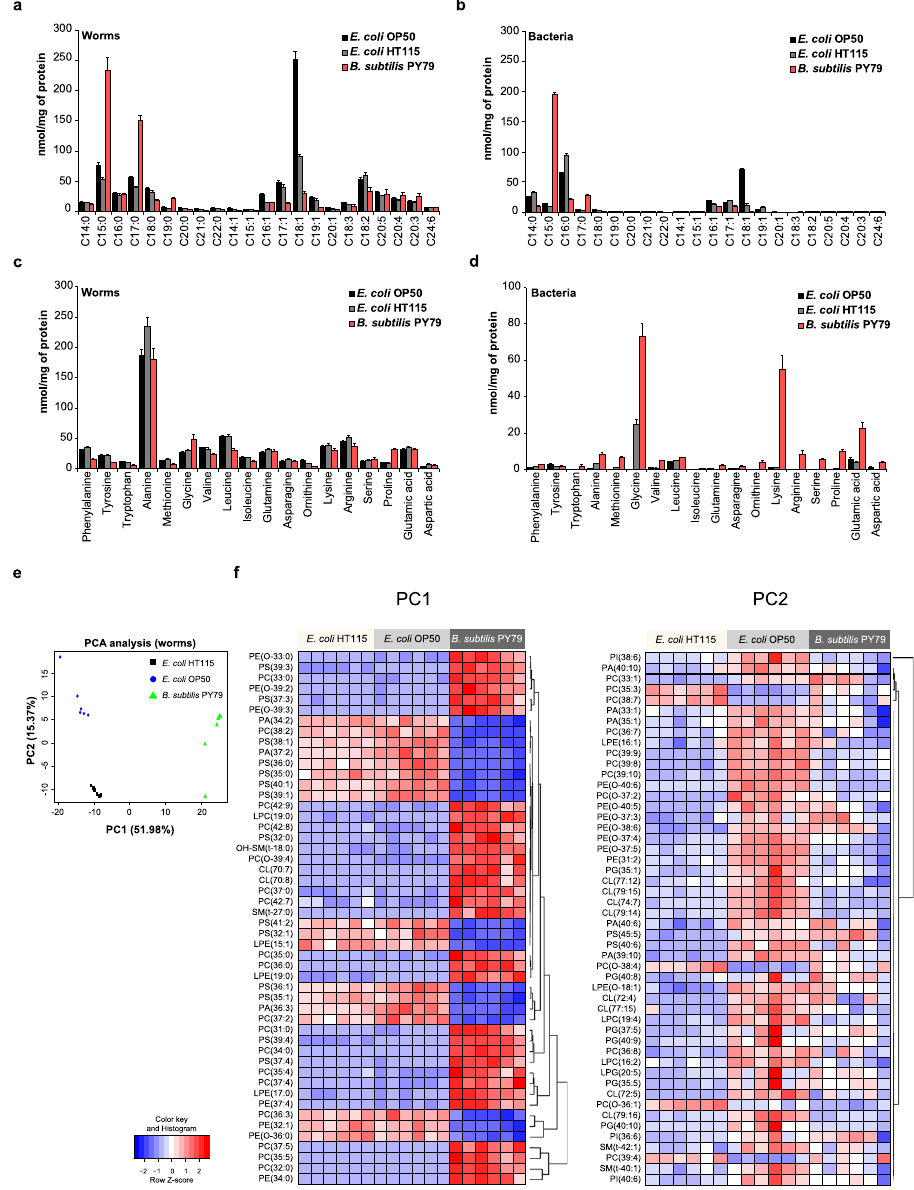
Figure 8. Metabolite changes in worms exposed to different bacterial diets. The effect of dietary intervention on worm metabolism was investigated by feeding N2 worms with three types of bacteria including E. coli OP50, E. coli HT115 and B. subtilis PY79. ( a ) FA composition of N2 worms fed with different bacterial diets. Worms fed an E. coli OP50 diet accumulated the highest abundance of C18:1 fatty acid. A relatively high abundance of C18:1 was also found in worms fed with the other E. coli strain HT115. Worms fed a B. subtilis PY79 diet accumulated odd chain fatty acids, such as C15:0 and C17:0. ( b ) FA composition of the three bacterial diets. The two E. coli bacterial strains were enriched with C14:0, C16:0 and C18:1, while B. subtilis PY79 bacteria were enriched with odd chain fatty acids C15:0 and C17:0. Polyunsaturated FAs were absent in all three bacterial strains. ( c ) AA composition of N2 worms fed with different bacterial diets. AA profiles of worms fed with different bacterial diets did not display marked changes. Worms fed the E. coli strains showed similar AA profiles, while feeding worms with a B. subtilis diet showed a high abundance of proline. ( d ) AA composition of the three bacterial strains. E. coli strains contained low levels of most AA species, except glycine, which is relatively high abundant in E. coli HT115. B. subtilis PY79 bacteria were enriched in many AA species, especially glycine, lysine and glutamic acid. ( e ) Principal Component Analysis (PCA) score plot showing group separation based on PL profiles in N2 worms fed with different bacterial diets. Worms fed a B. subtilis PY79 diet were clearly separated from those fed with an E. coli diet, and a distinctive separation was evident between worms fed OP50 or HT115 E. coli . ( f ) PL composition in N2 worms fed with different bacterial diets. The metabolites contributing most to the groups’ separation based on PC1 and PC2 of the PCA are shown. Bar graphs are expressed as mean ± SD. See also Supplementary Fig. S5 and Suplementary Table